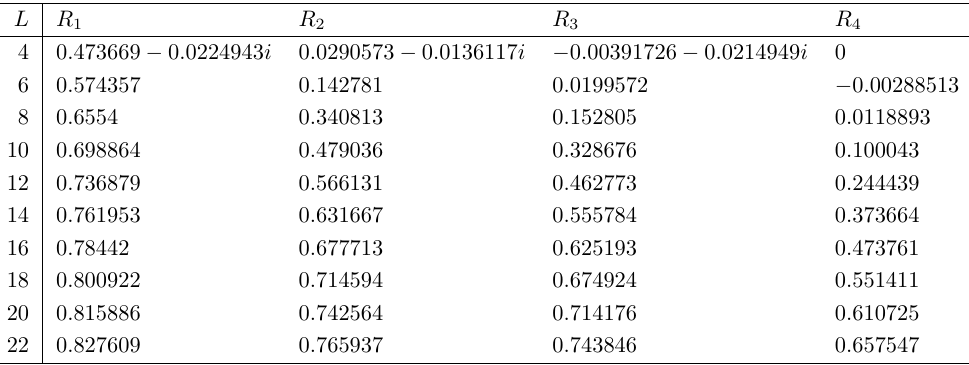
Figure 22 . Plots of the imaginary part of R 1 (A.3) of Φ D and dashed lines are extrapolations to L = 4 k + 2 ( k → ∞ ) and L = 4 k ( k → ∞ ), respectively. The horizontal axis denotes the value of the parameter a .